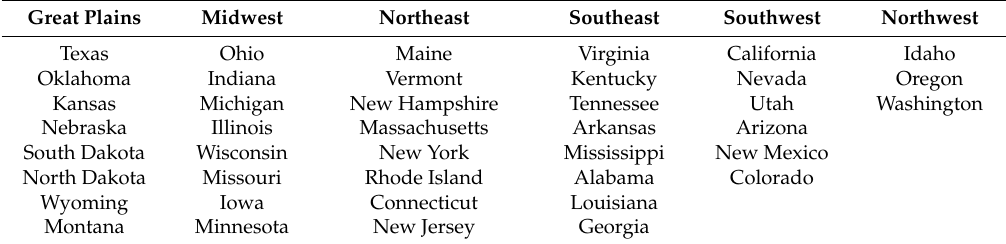
Table 1. NCA regions and the constituent